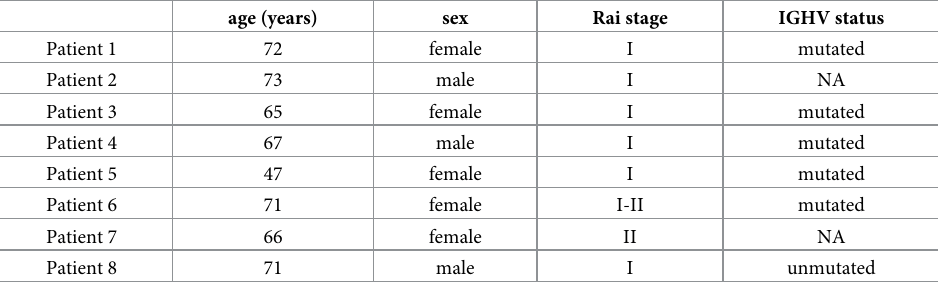
Table 2. Characteristics and clinical data of B-CLL patients at the time of the